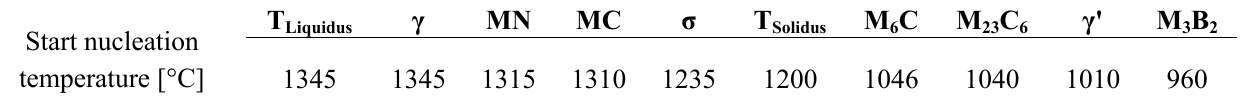
Table 6. Calculated nucleation temperature for Haynes ® 282 ®